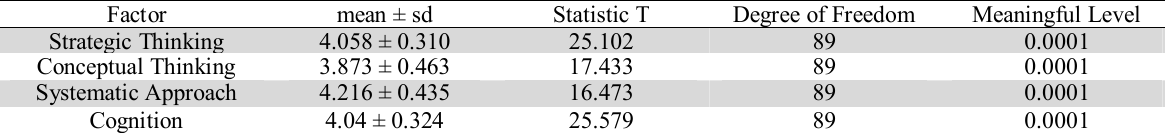
The Results of Single-Sample T Test; the Levels of Strategic Thinking, Conceptual Thinking, Systematic Approach and Cognition Variables Factor mean ± sd